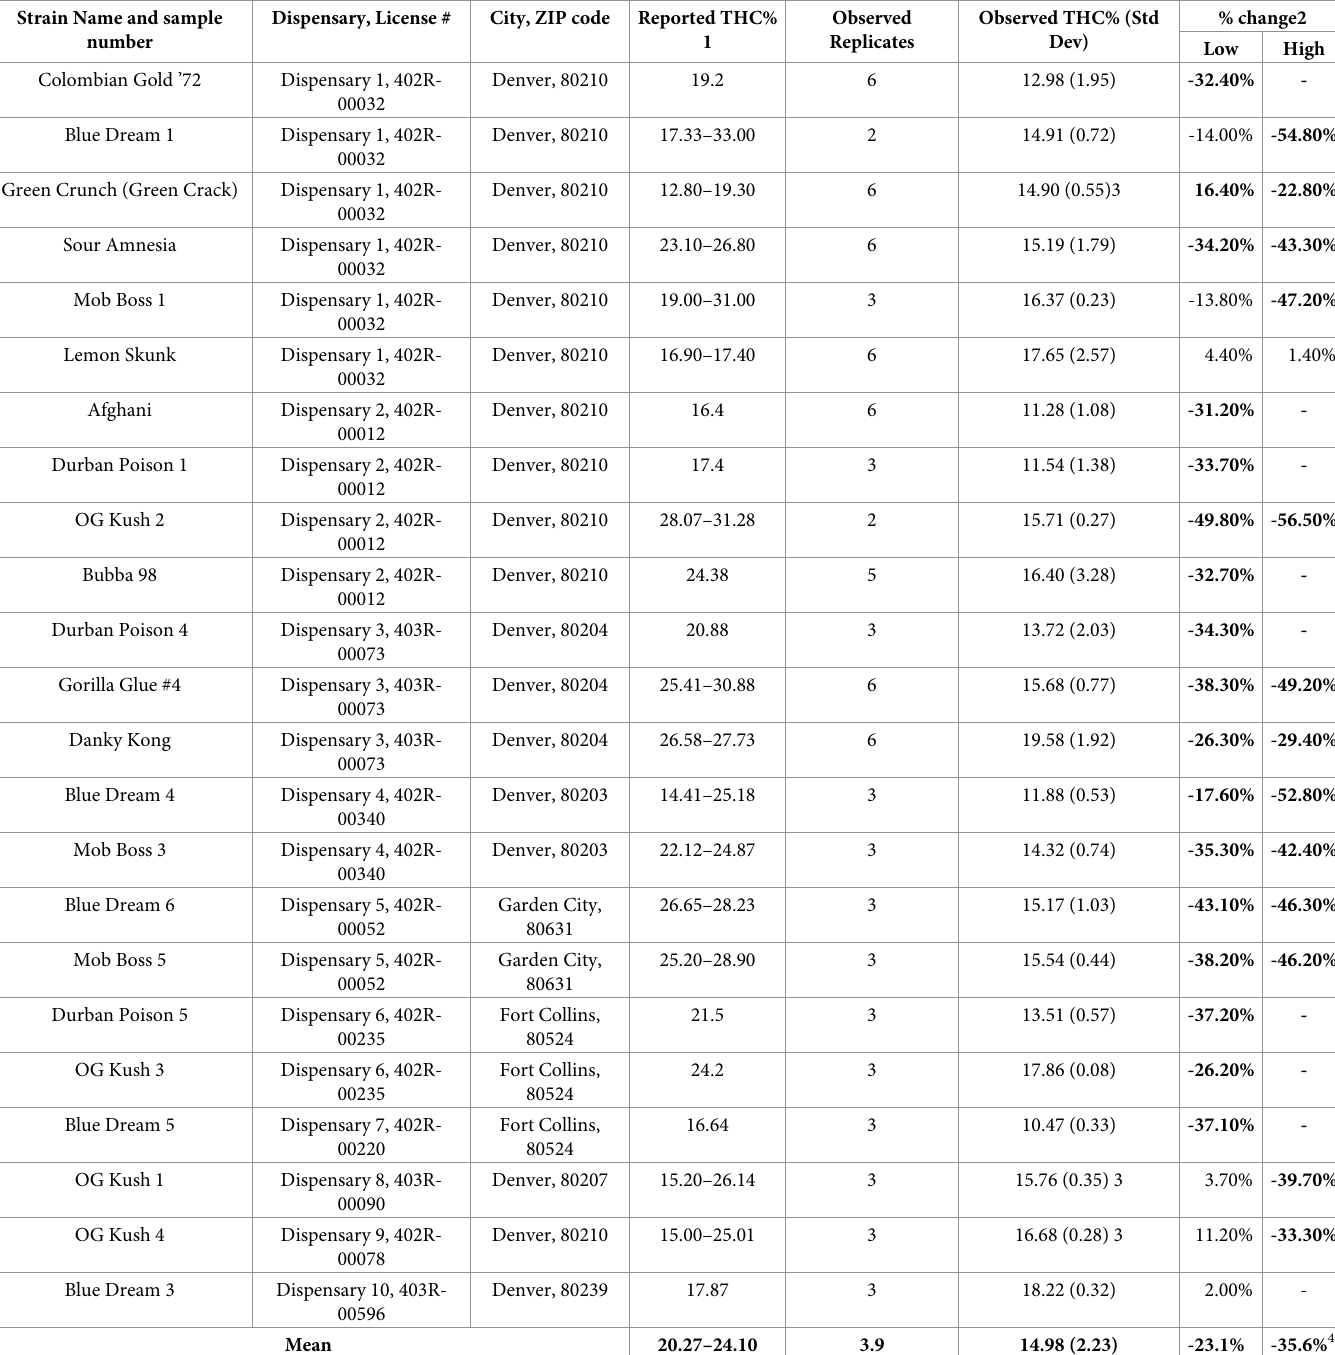
Table 1. Reported and observed THC % by dry weight from Colorado